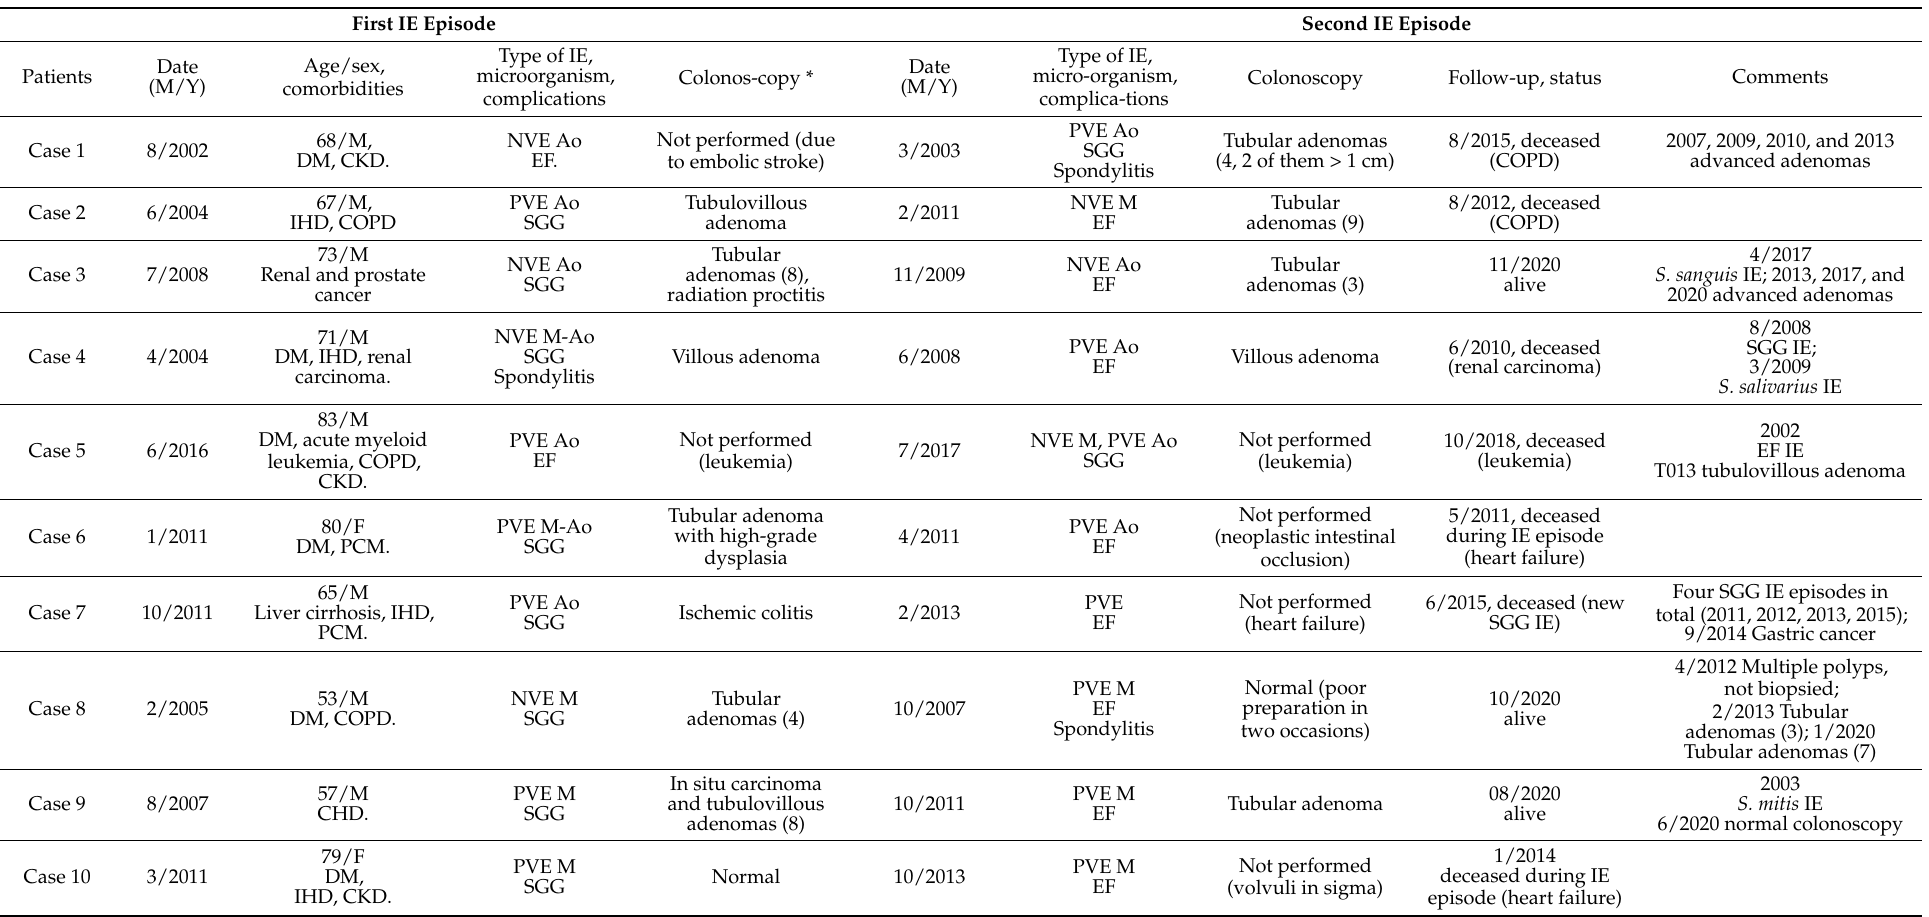
Table 1. Characteristics of 20 recurrent episodes of endocarditis caused by either Enterococcus faecalis or Streptococcus gallolyticus subsp. gallolyticus in 10